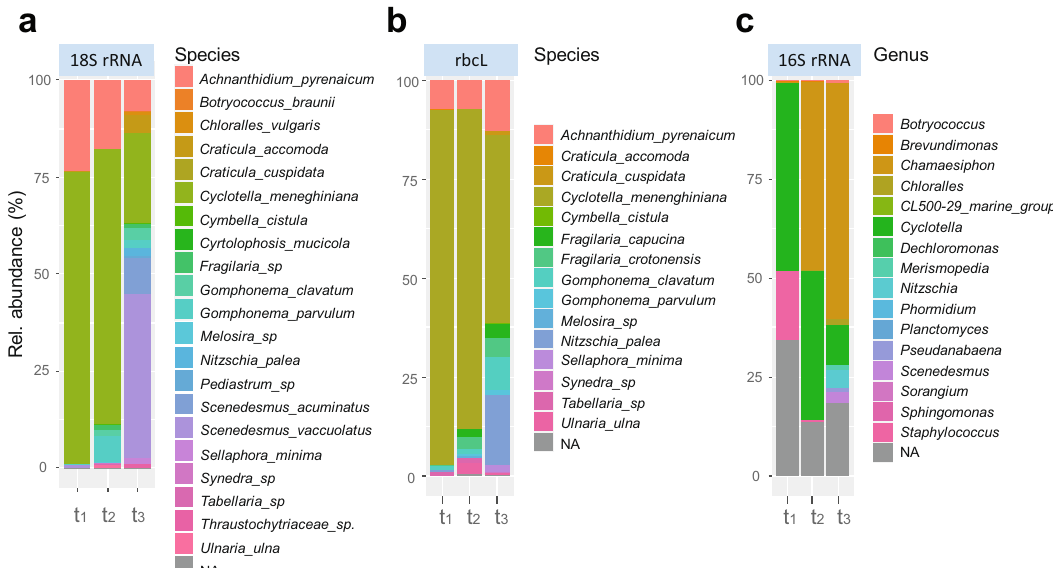
Fig. 4 Genetic composition of the synthetic periphyton at the species level. Community composition pro fi le and relative abundances (average; n = 9) were inferred from taxonomy-based clustering at species level of assigned 18S rRNA ( a ) and rbcL ( b ) gene sequences and at genus level of assigned 16S rRNA ( c ) at 4 (t 1 ), 18 (t 2 ), and 30 days (t 3 ) during periphyton formation. NA: not assigned